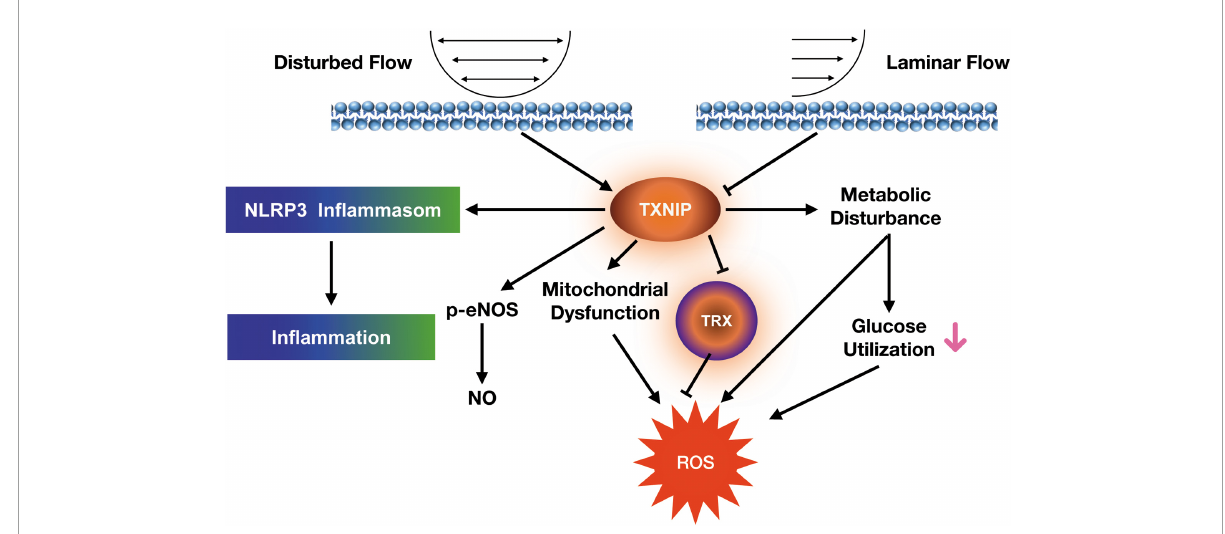
FIGURE7 Proposed signaling mechanism linking shear stress to endothelial dysfunction in